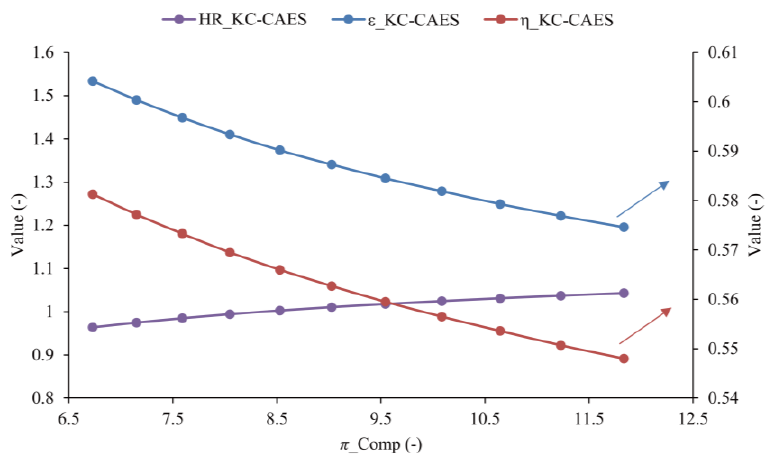
π on performance parameters of KC-CAES. Figure 5. Effect of π Comp on performance parameters of KC-CAES. Figure 5. Effect of Comp